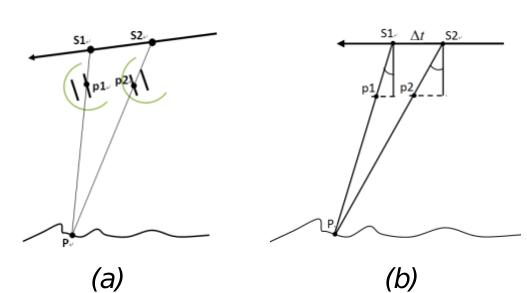
Figure 2. Geometrical imaging relationship between bands (a) in perspective, (b) in plan (Wang, et. al. , 2013) Once the relationship is established, the band-to-band registration becomes re-sample